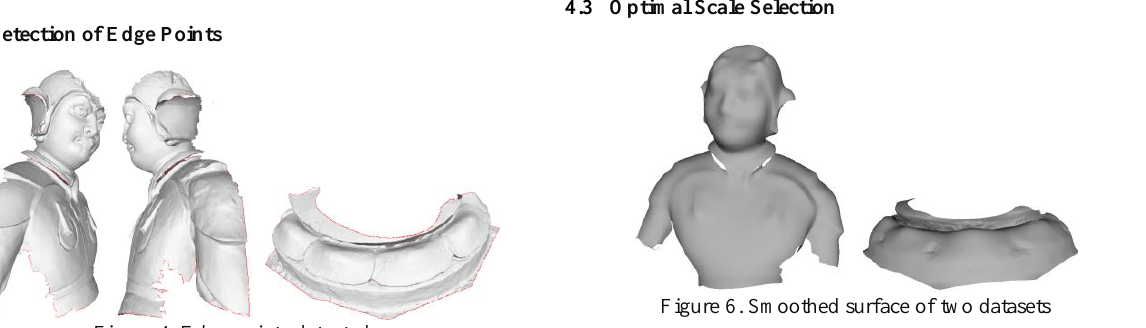
Figure 4. Edge points detected